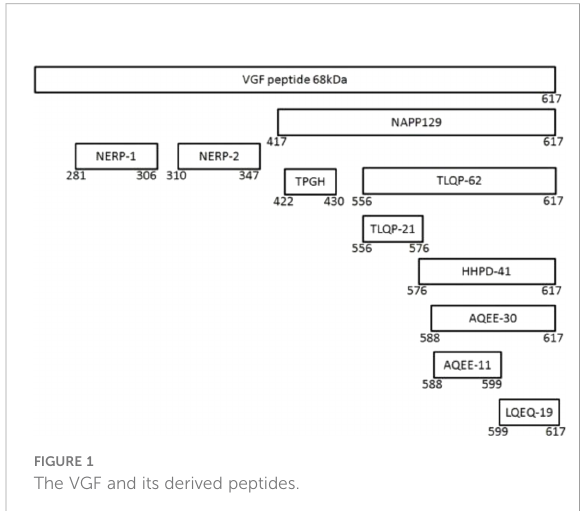
FIGURE 1 The VGF and its derived